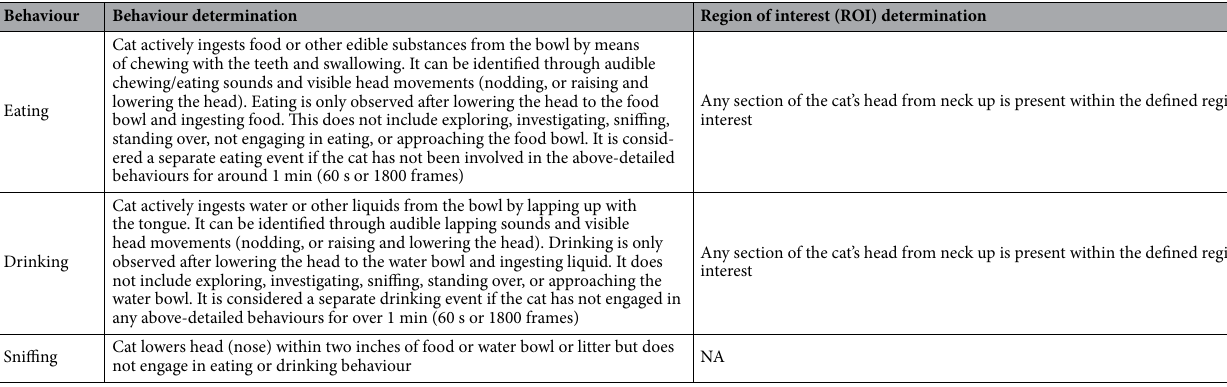
Table 2. Ethogram for behaviour coding of post-event processing and real-time video monitoring of eating, drinking, sniffing, and region of interest (ROI) presence. Note: Presence within ROI not recorded for real time